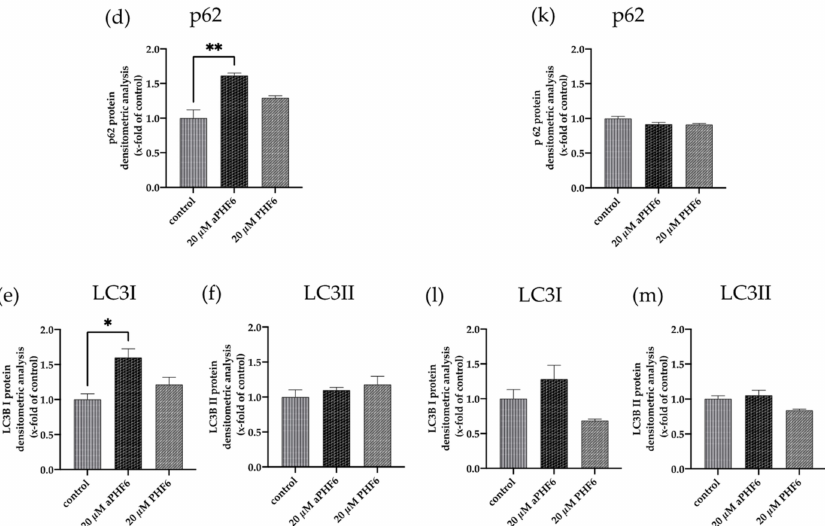
Figure 8. Autophagy markers p62, LC3I, and Beclin-1 are increased after 6 h aPHF6. ( a , b ) WB analysis of Beclin-1 confirmed the elevated gene expression after 6 h of aPHF6 stimulation ( g , h ), whereas no changes were observed at the later stage. ( c , d ) After the short-term stimulation, higher levels of the p62 autophagosome protein were measured, which returned to control levels at the later stage ( i , k ). ( e ) On the contrary, LC3I was increased after 6 h, but no changes were detected on the LC3II form ( f ). ( l , m ) After 24 h, no significant changes were measured at all. * p < 0.05; ** p < 0.01; *** p <